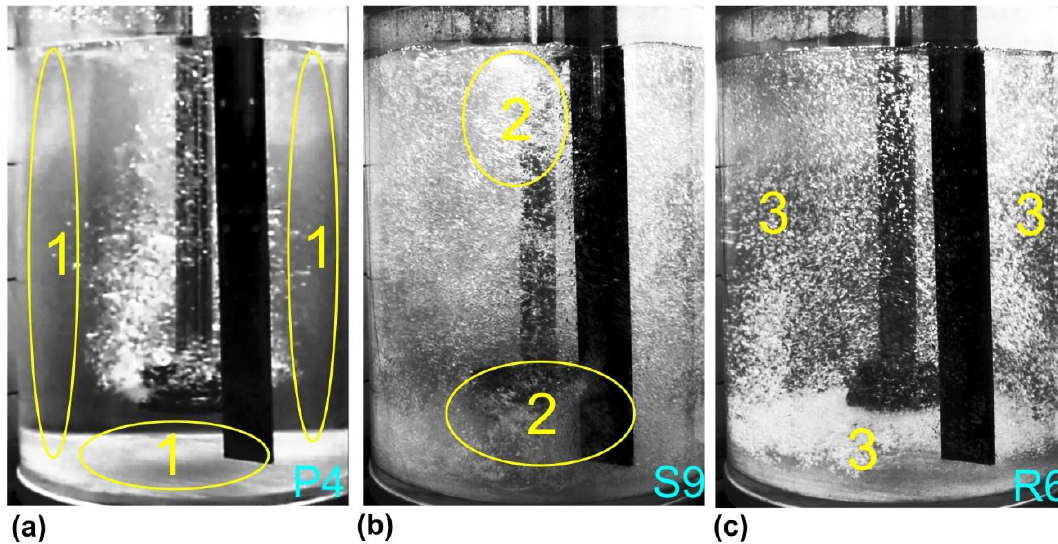
Figure 6. The exemplary variants of dispersion level with marked places indicating dead zones without mixing (1), swirls and chains of bubbles (2), and areas of uniform mixing of gas bubbles with water (3): ( a ) minimal dispersion, ( b ) excessive dispersion, ( c ) uniform dispersion. Table 3. Summary of visualization results—different types of gas bubble dispersion in water, for flow rate of refining gas in range: 10–20 L·min −1 , and rotary impeller speed: 5.00–8.33 s −1 , for three studied rotary impellers.